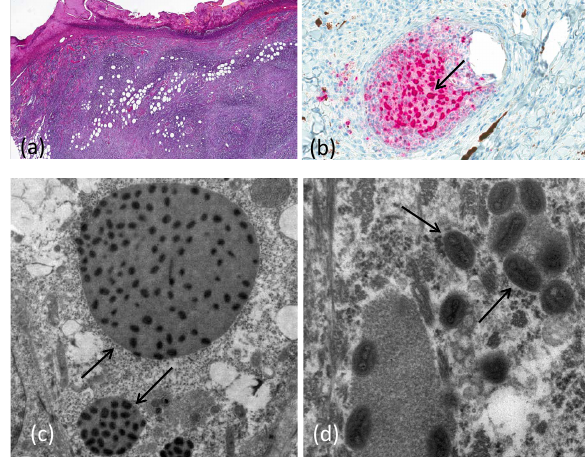
Table 2. Detection of infectious particles in saliva.